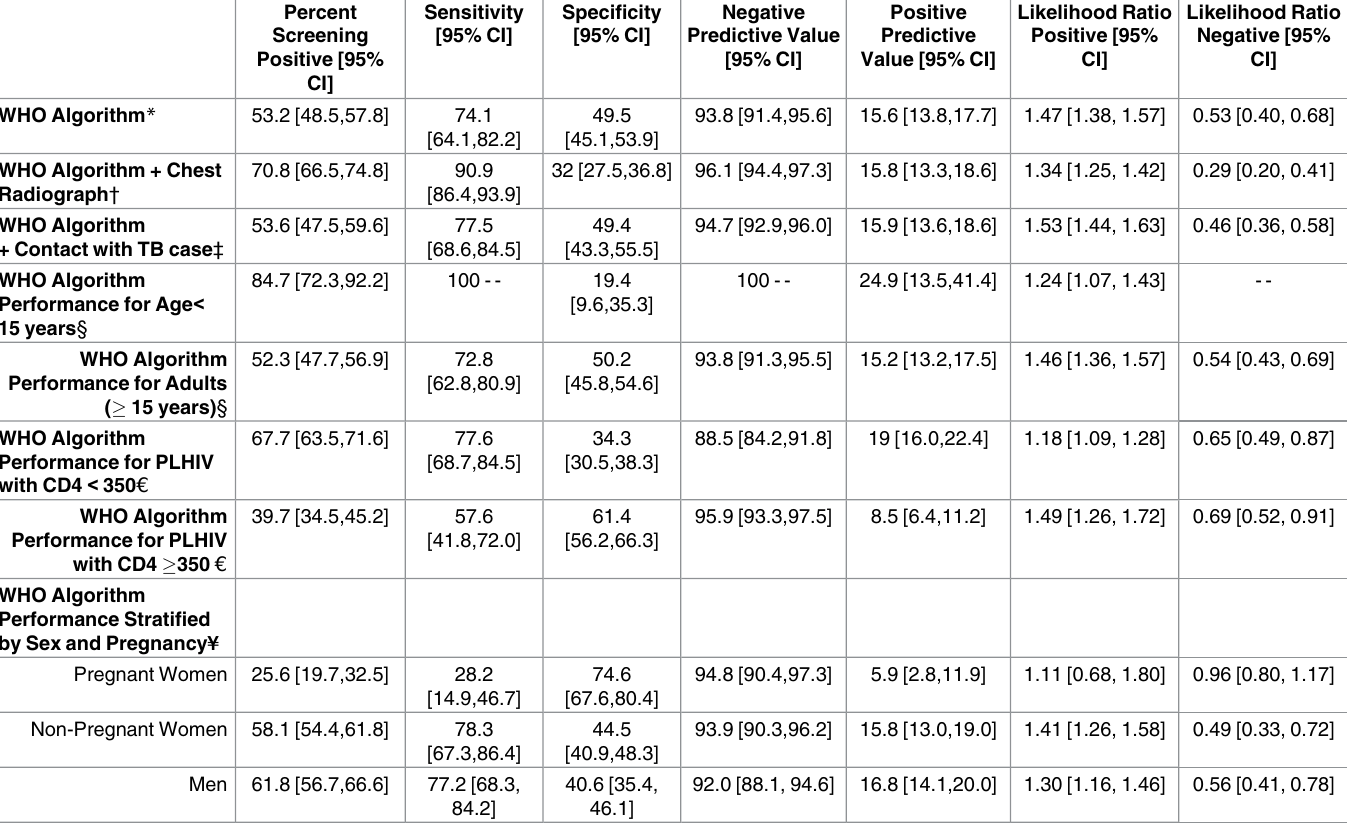
Table 2. Performanceof World Health Organization (WHO) Tuberculosis (TB) Intensified Case Finding Algorithm in People Living with HIV (PLHIV) in